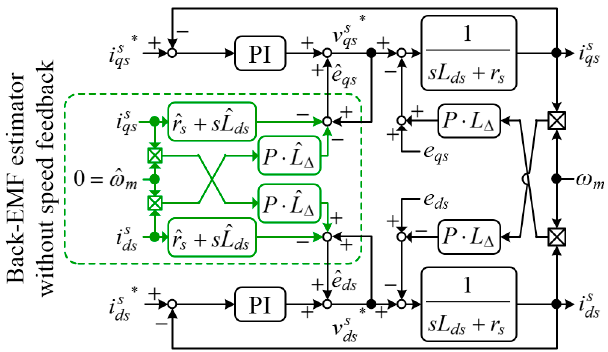
Figure 8. Figure 8. Current controller with the decoupling voltage from the back-EMF estimator during restarting period.